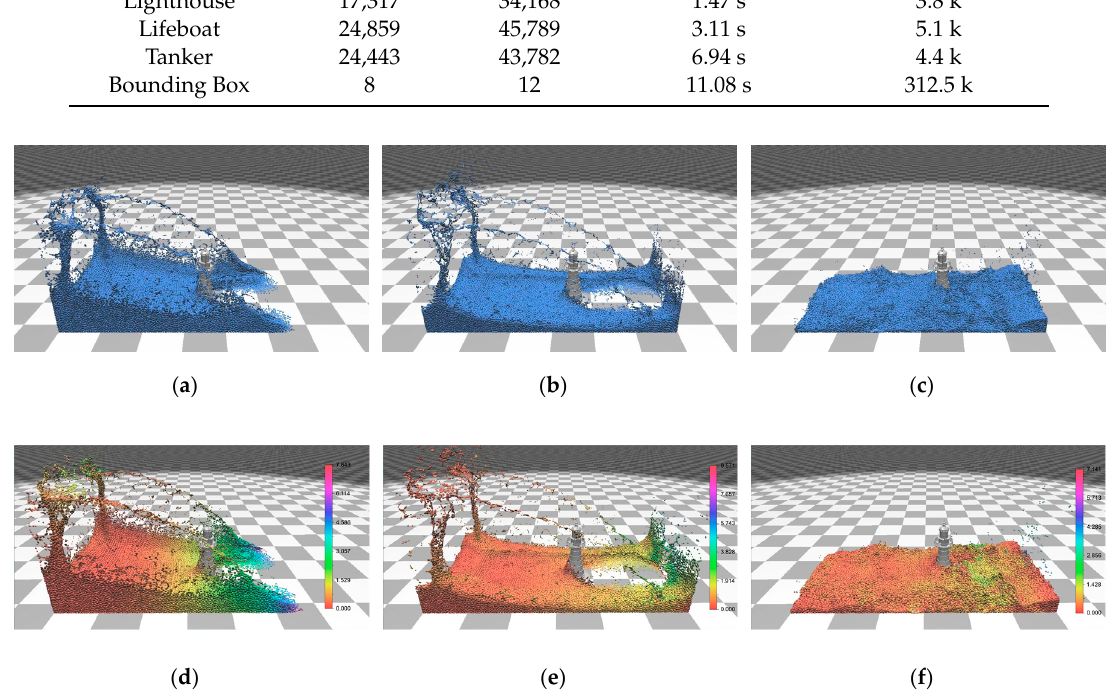
Figure 8. Scene of waves crash against the lighthouse with 53.2 k fluid particles: ( a – c ) the di ff erent stages of the lighthouse scene, which are selected from three di ff erent time steps; and ( d – f ) the velocity distributions of fluid particles. The time instances in ( a – c ) are the same as in ( d – f ), respectively. The color bars on the right side of ( d – f ) denote the modules length of the velocity (velocity is a three-dimensional vector). The unit of velocity in ( d – f ) is m /